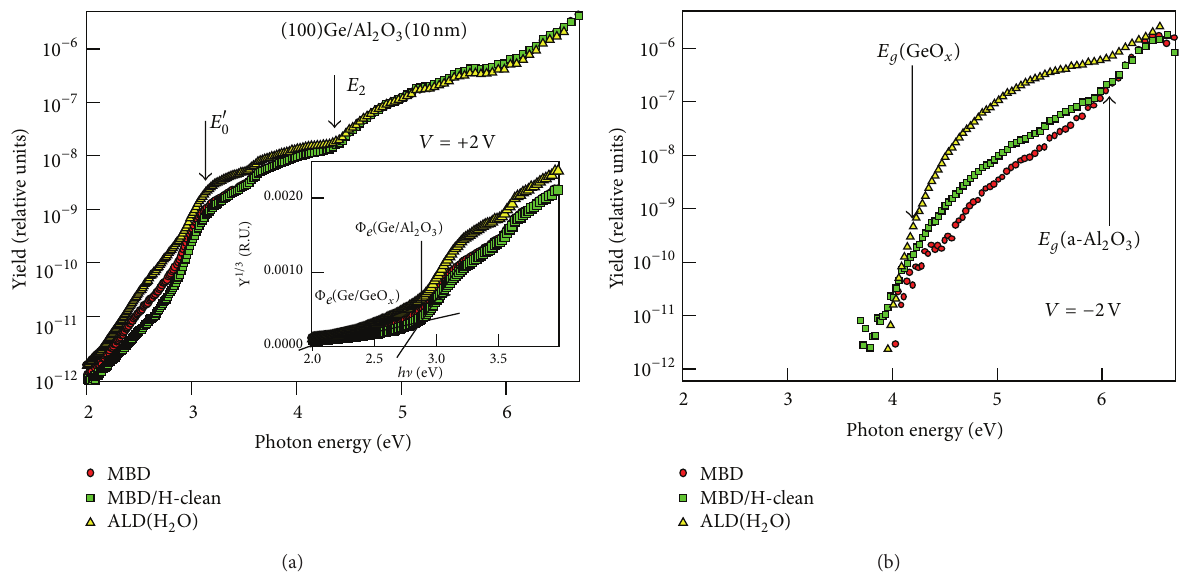
Figure 16: Semilogarithmic plot of the photocurrent yield spectra of (100)Ge/a-Al 2 O 3 (10nm)/Au capacitors fabricated using different alumina deposition methods as measured under (a) positive and (b) negative bias of 2 Volt applied to the top metal electrode. The inset in panel (a) illustrates determination of the electron IPE spectral thresholds using 𝑌 1/3 - ℎ ] plots. The threshold energies Φ 𝑒 are indicated for electron transitions from the VB of germanium into the CB of a-Al 2 O 3 and into the CB of GeO 𝑥 IL formed during oxide deposition. The vertical arrows 𝐸 󸀠 0 and 𝐸 2 in panel (a) mark the energies of direct optical transitions in the Ge crystal. In panel (b) the vertical arrows mark the onsets of the photoconductivity in a-Al 2 O 3 film and GeO 𝑥 IL.